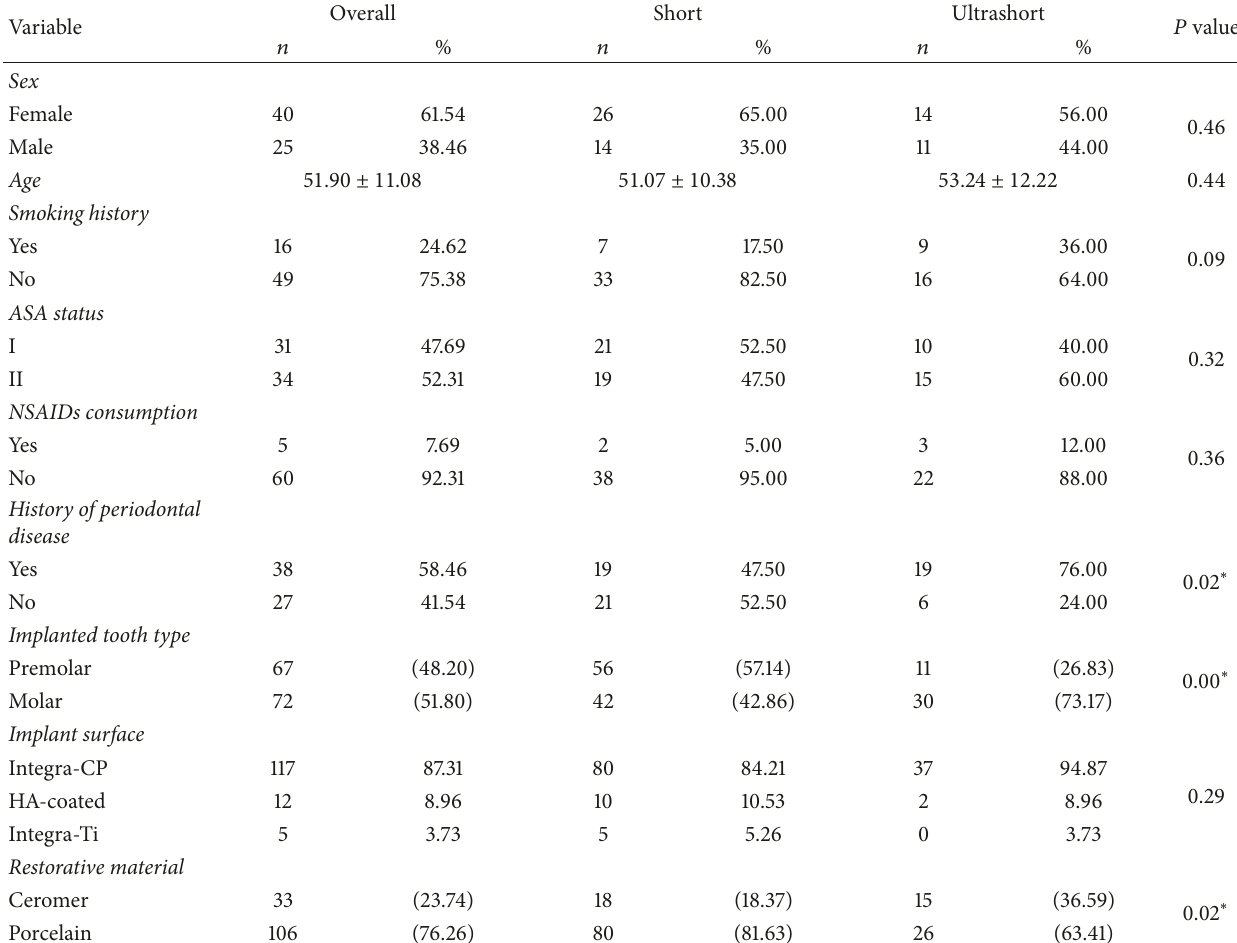
Table 1: Overall placed implants according to studied covariates. Also distribution of placed implants according to implant length is presented in this